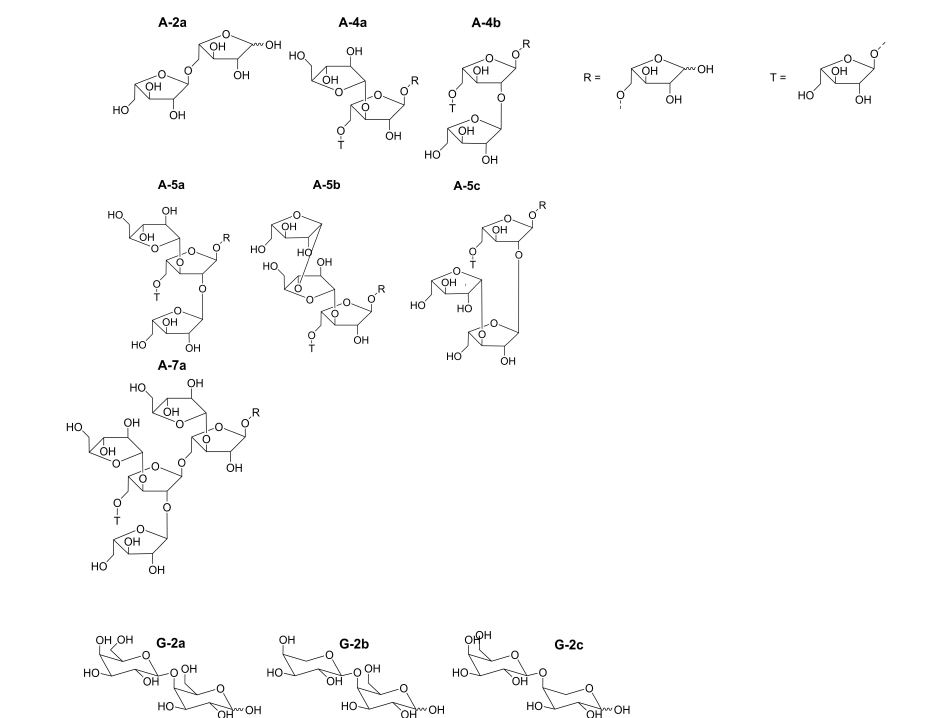
Figure A1. Structures of arabinan and galactan oligosaccharides of raw and extruded apple pomace dietary fiber after enzymatic cleavage by endo -arabinanase and endo -galactanase. R: reducing end, T: terminal